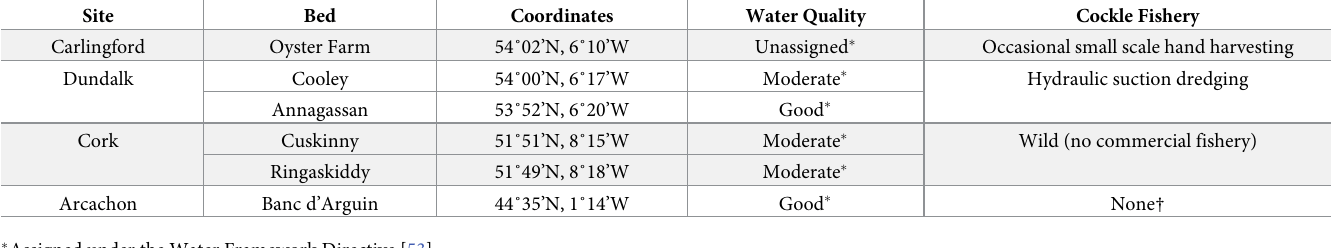
Table 1. Description of the four sites and the beds examined within. Typical activities occurring in the general area of the sites are described.